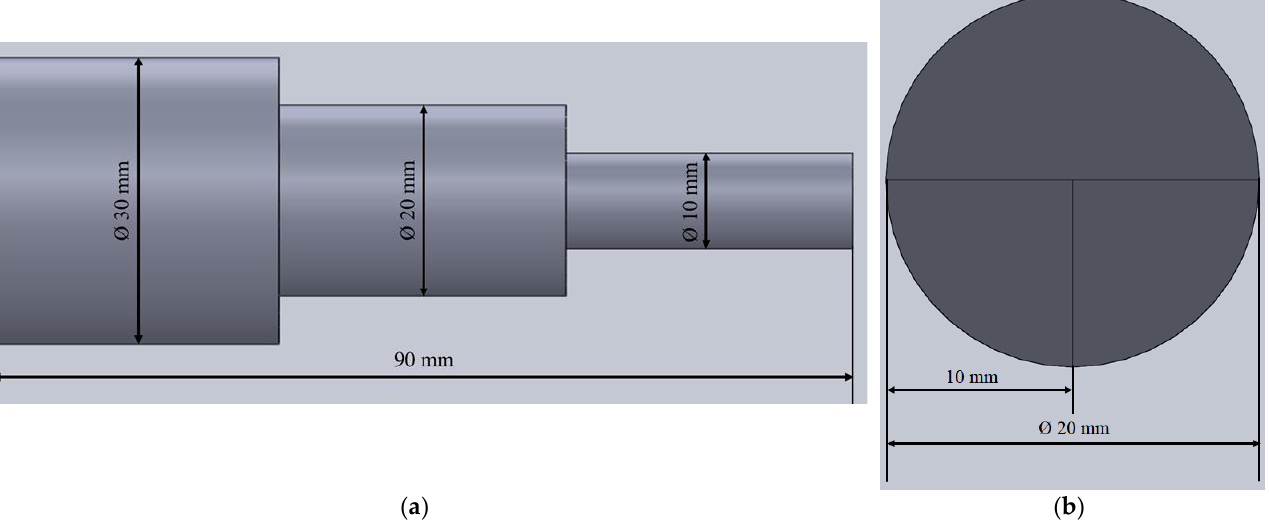
Figure 1. The cast sample geometry with: ( a ) Indicated dimensions; ( b ) Indicated sampling for corrosion testing.